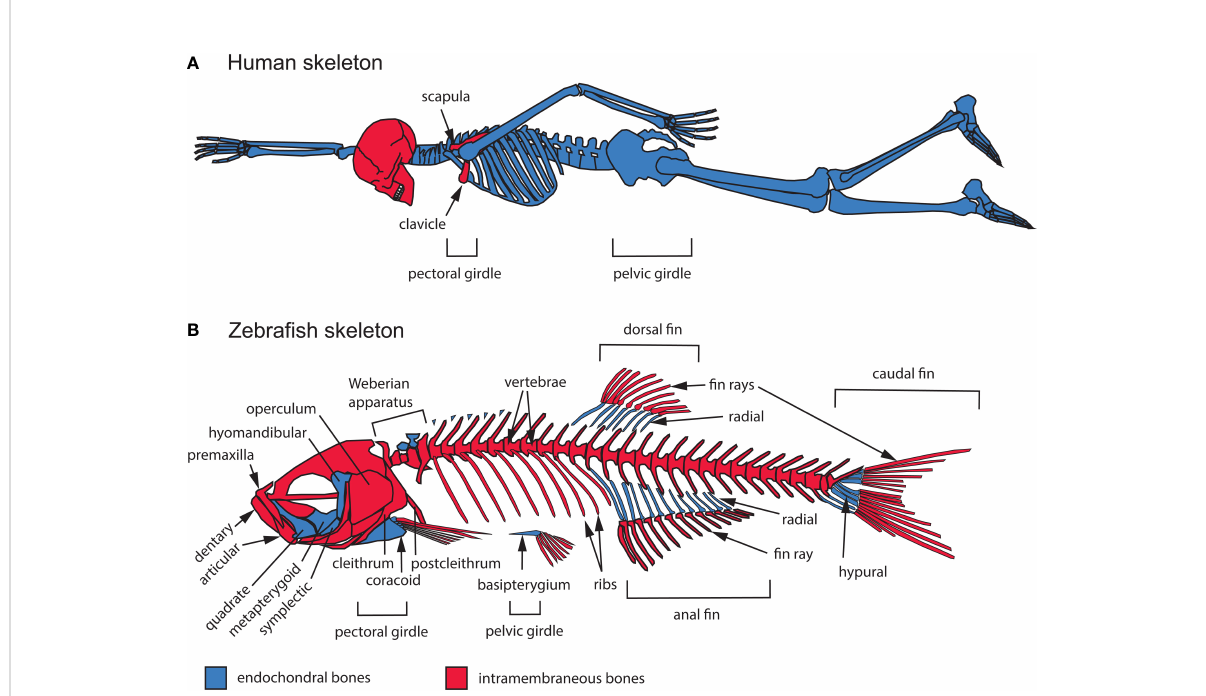
FIGURE 1 General overview of the intramembranous and endochondral composition of the zebra fi sh and human skeletons. (A) Human adult skeleton. In the head, intramembranous bones such as those of the calvaria (the top portion of the neurocranium) dominate the human skull in surface area, while endochondral bones mostly occupy the cranial base. All of the bones that compose the trunk and appendicular skeletons are endochondral, except for portions of the clavicle and scapula. (B) Zebra fi sh adult skeleton. The zebra fi sh skull, trunk and appendage skeletons are composed of both intramembranous and endochondral bones. The zebra fi sh skull is composed of 134 bones, 78 of which are endochondral. The zebra fi sh trunk skeleton is composed of intramembranous vertebrae and ribs. The zebra fi sh appendage skeleton is composed mostly of endochondral bones, while the fi n ray exoskeleton is completely